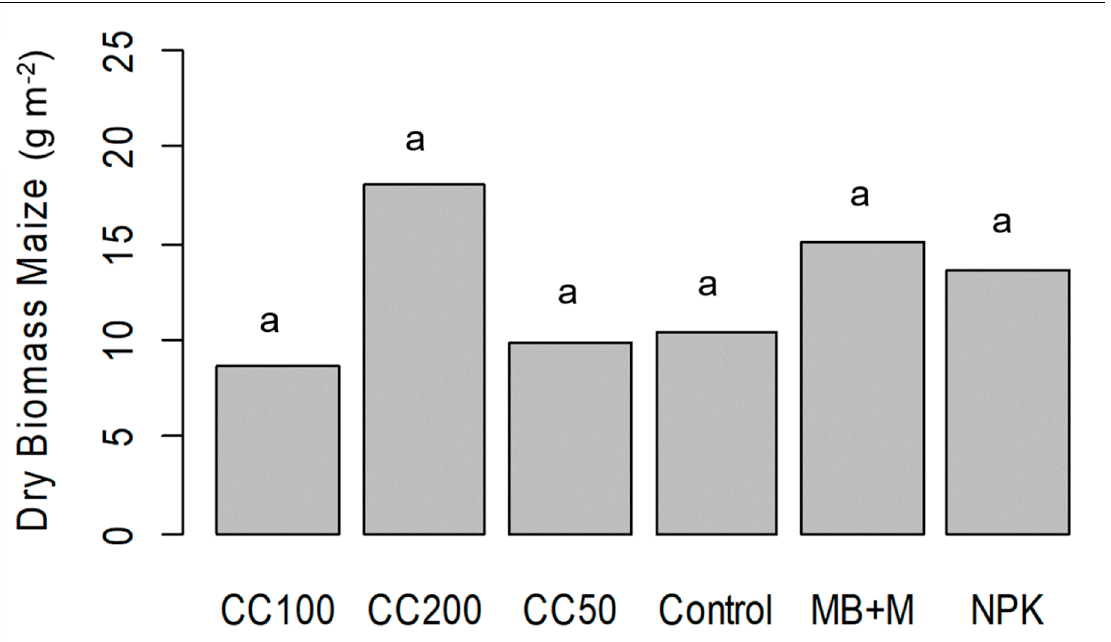
Figure 3. Maize dry biomass in response to maize–mung bean intercropping (MB+M), ComCat ® (CC) treatments at rates of 50, 100, and 200 g ha − 1 and mineral fertilizer application (NPK) at Matéri, Benin, 28 DAS. Treatments with identical letters above columns did not differ significantly based on Tukey’s HSD test.